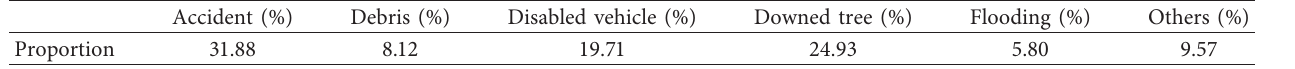
Table 1: Type of incidents during evacuation period.